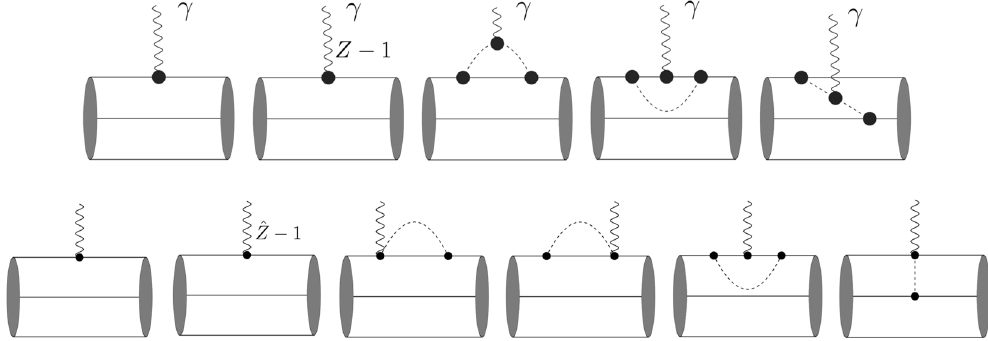
Figure 3. Feynman diagrams contributing to the octet baryons electromagnetic form factors (upper panel) and axial form factors (lower panel) up to one-loop